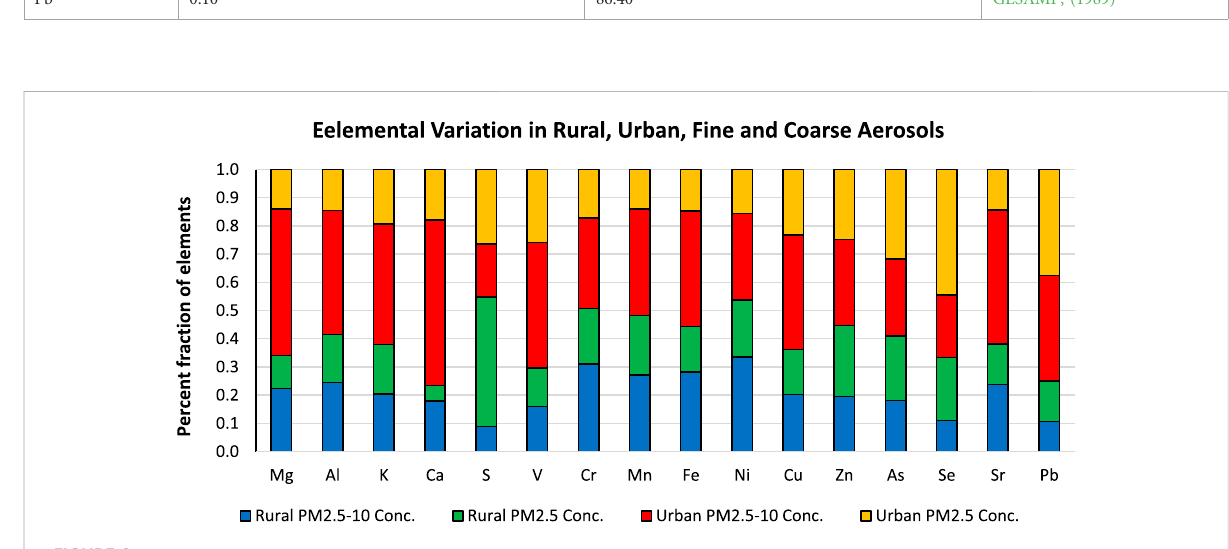
FIGURE 2 Variations of PM elemental concentrations under different environmental